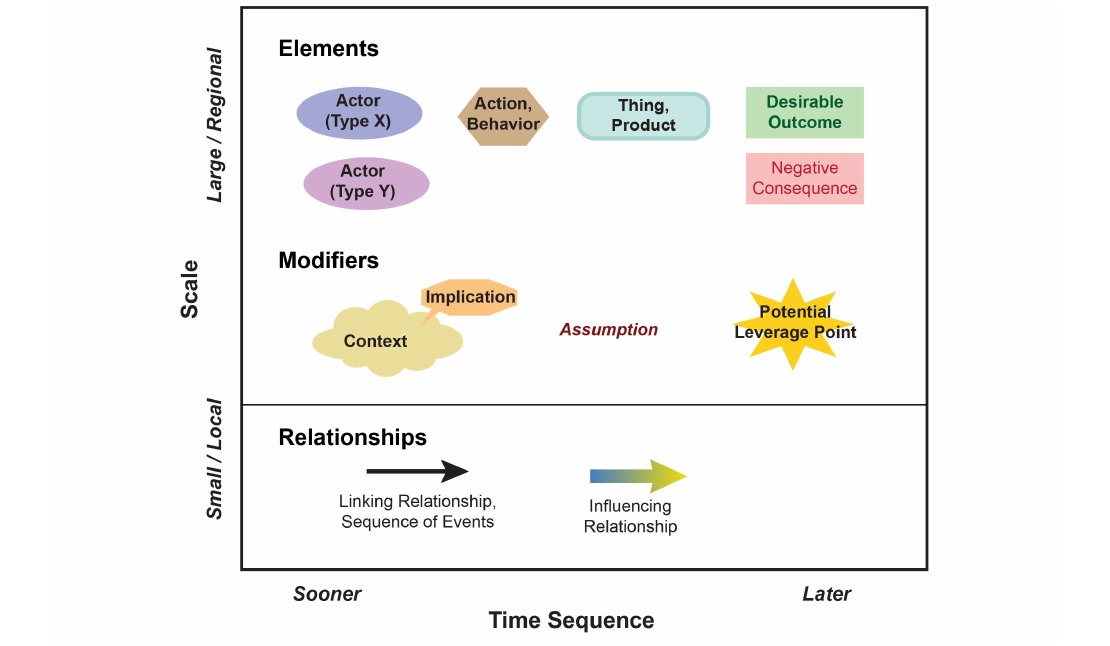
Fig. 2 . Symbol key showing the visual “grammar” used for the graphic interview summaries and conceptual model(s) produced during an exploratory problem assessment process. This visual design strategy draws on information and visual design principles to produce information-rich diagrams. Visual separation is achieved by using colors, shapes, and line weights to differentiate objects and arrows indicating different types of actors, actions, and relationships, along with underlying assumptions and influential contexts. Layering is achieved by using the vertical axis to indicate the scope of decision making and scale of natural features, and the horizontal axis to show the sequence in which actions and events are expected or need to